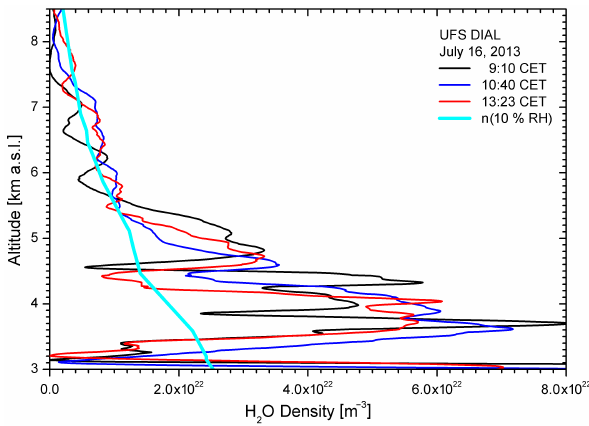
Figure 16. Water-vapour profiles obtained with the UFS DIAL on 16 July 2013 together with the 10% RH curve from the Stuttgart radiosonde (Munich data not being available); the layer with most aerosol is extremely dry suggesting the presence of stratospheric air. Also in the aerosol layer around 4.5km relative humidity values of the order of just 5% are seen indicating a strong stratospheric